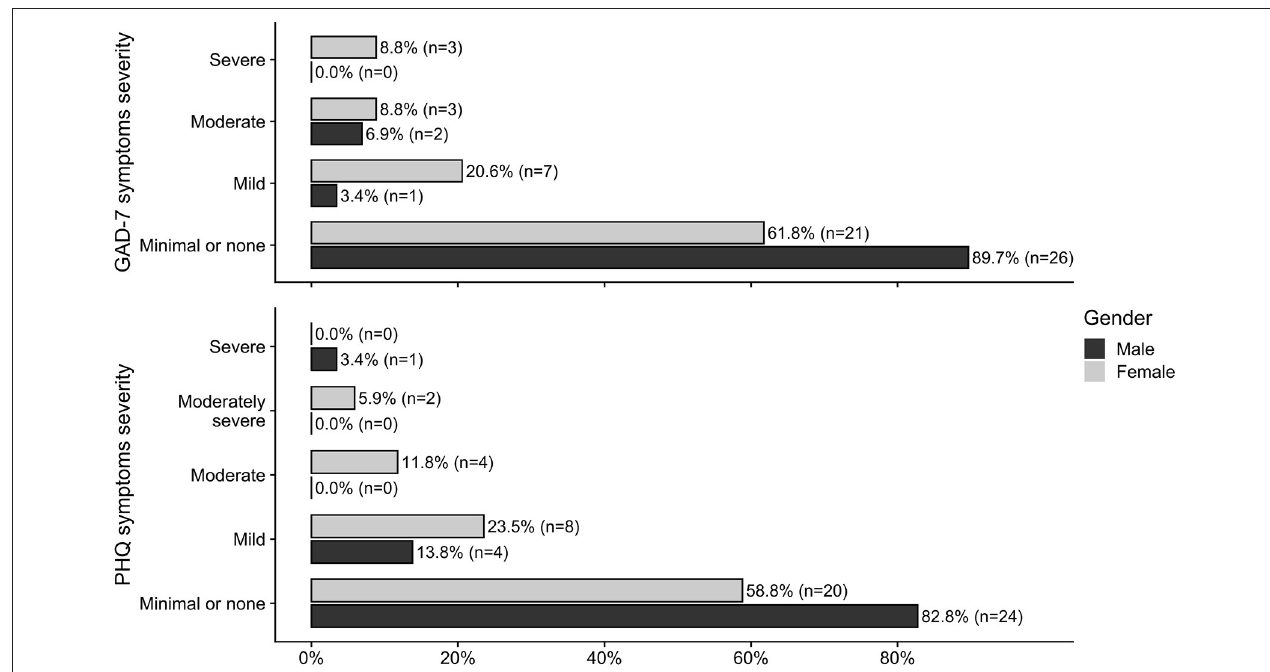
FIGURE 2 | Counts and within-group percentages for females and males classified in diagnostic categories of degrees of the severity of symptoms measured by GAD-7 and PHQ-8.